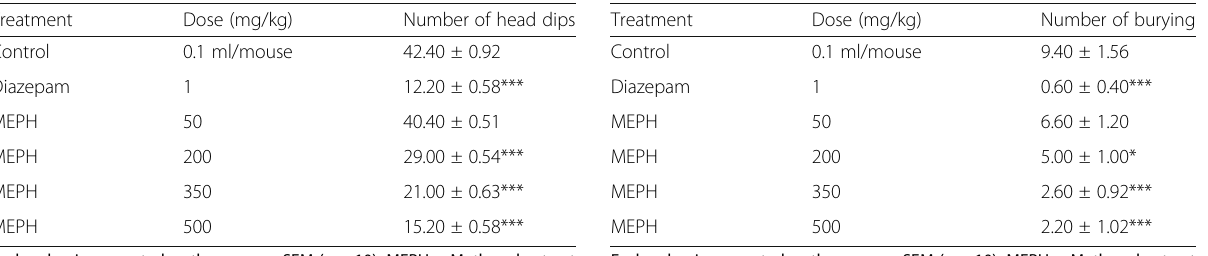
Table 9 The effect of MEPH on marble-burying test in